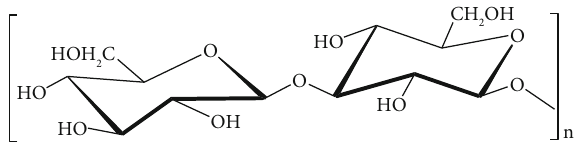
Figure 1: Repeated structural units of LJP.